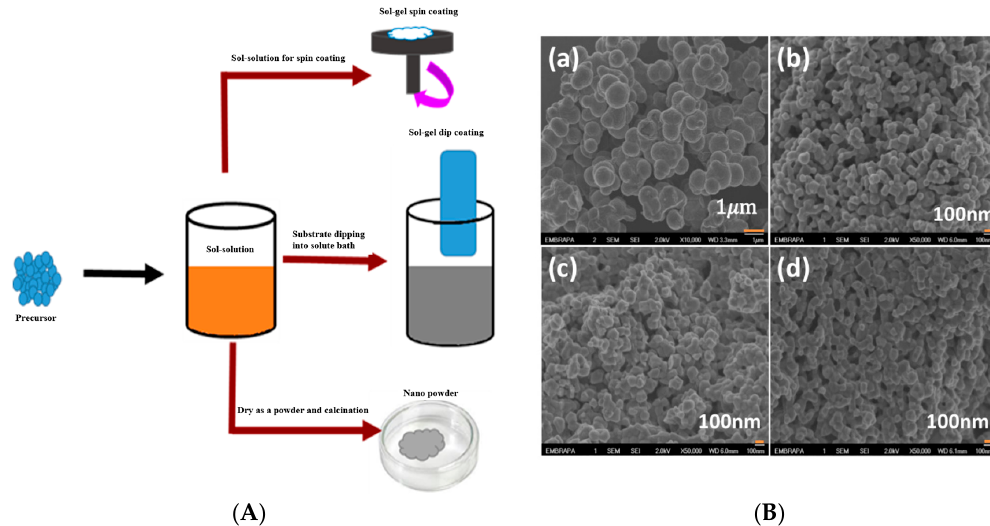
Figure 7. ( A ) Sol-gel Processing Schematic Diagram, ( B ) SEM micrographs of Nb 2 O 5 : (a) Sol-gel (NH 4 OH) Nb 2 O 5 —750 @BULLET C for a resolution of 1 µ m; (b) Pechini (NH 4 OH) Nb 2 O 5 —750 @BULLET C for a 100 nm resolution; (c) Pechini (HCl) Nb 2 O 5 —750 @BULLET C for a 100 nm resolution; and (d) pechini (HNO 3 ), Nb 2 O 5 —750 @BULLET C for a 100 nm resolution